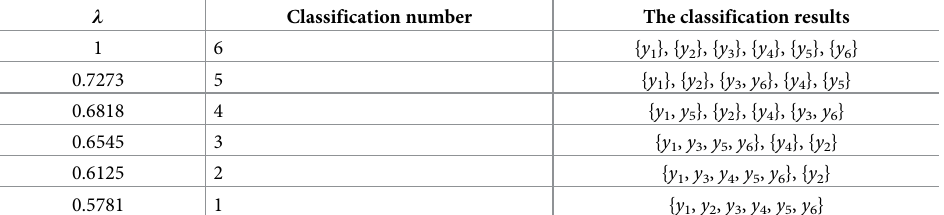
Table 5. Clustering results of the original matrix.